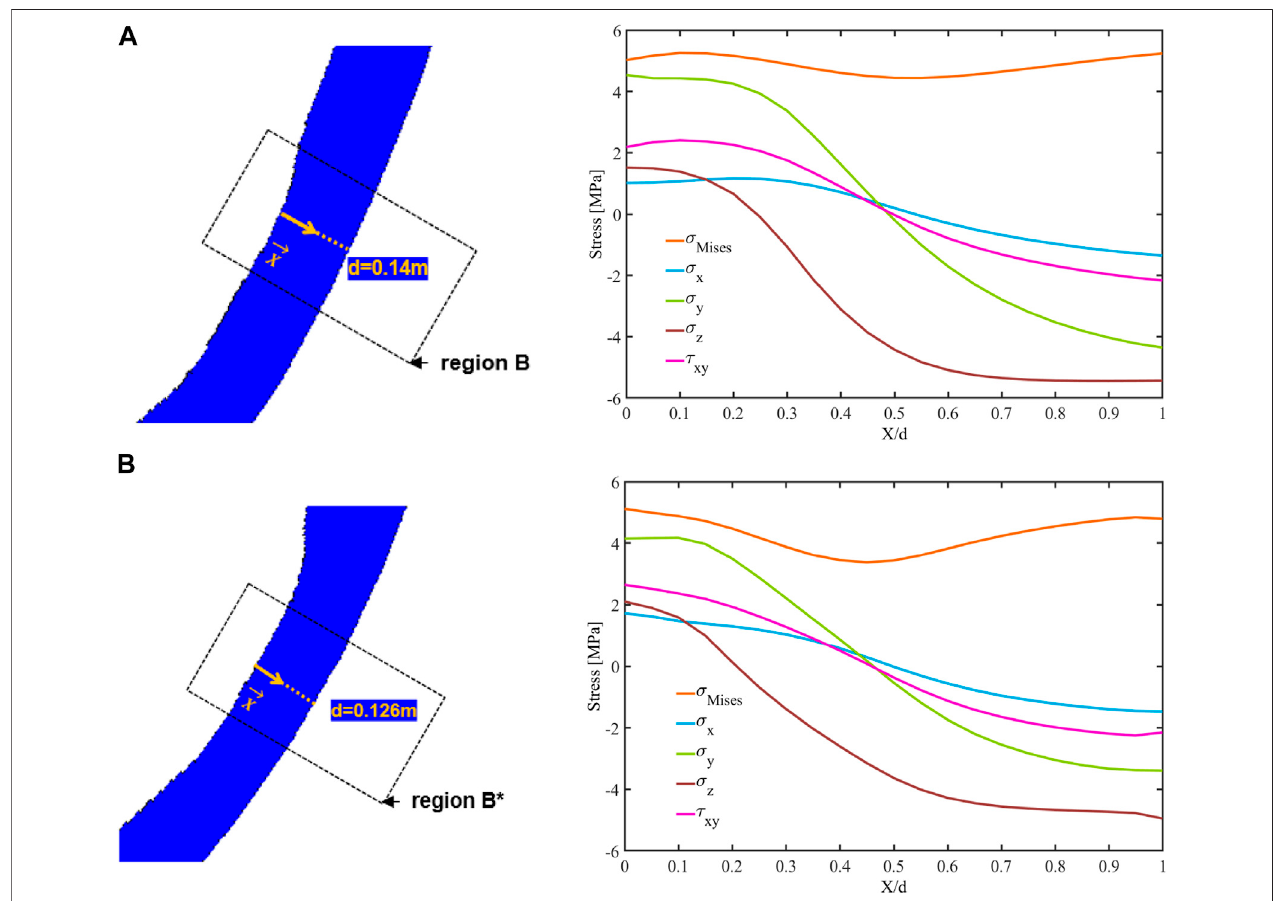
FIGURE 14 | (A) The stress component distributions along the thinnest region (region B) of the RPV lower head for the SBO case at failure time t = 6.8 h. (B) The stress component distributions along the thinnest region (region B*) of the RPV lower head for the SBO + LOCA case at failure time t = 7.1 h.